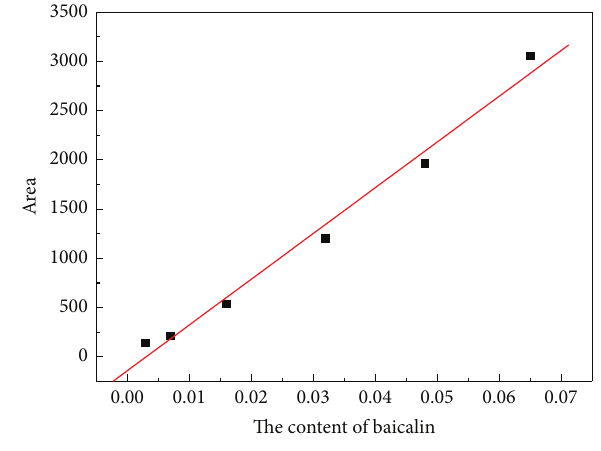
Figure 1: Baicalin standard curve.